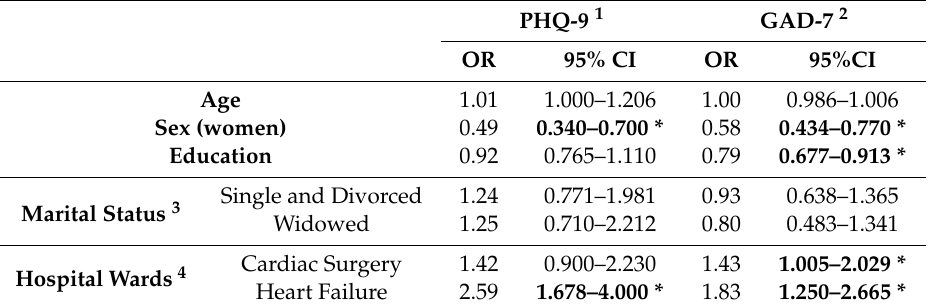
Table 5. Multivariate analysis: Risk factors for both anxiety and depressive